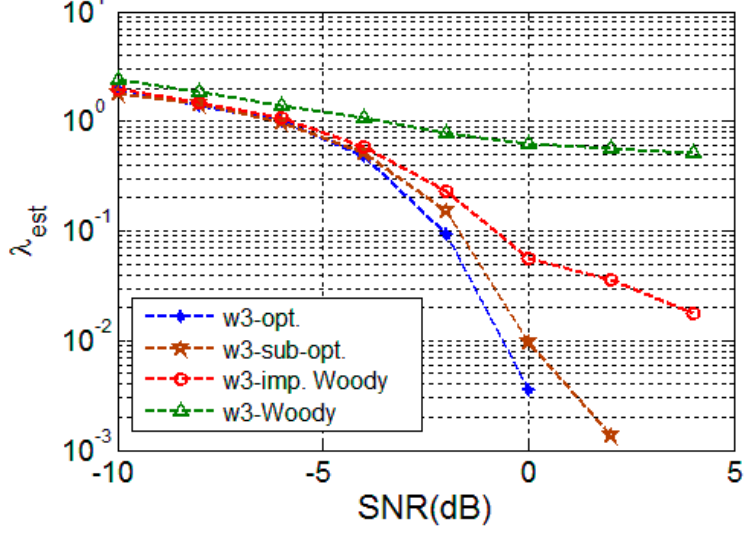
Figure 5. TDE performance for deterministic signal (w3).